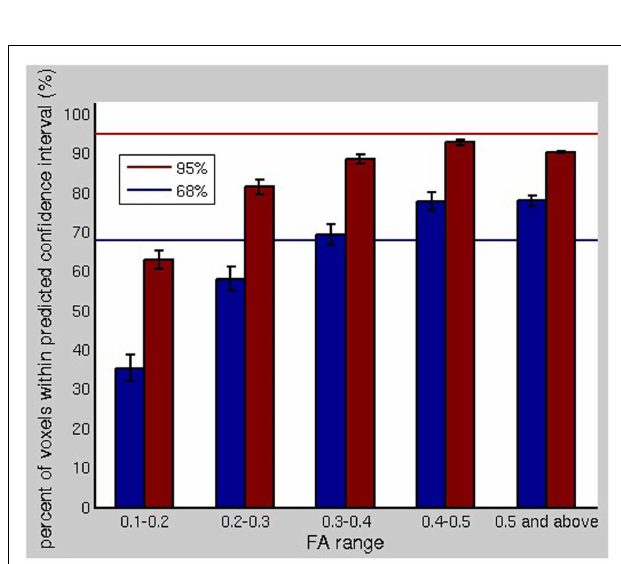
FIGURE 6 |The comparison of the bootstrap uncertainty profiles for fiber orientations is shown .The blue and red bars show the percent of the voxels in the brain for which the fiber orientations, computed without bootstrapping, lay within the 68 and 95% bootstrap-predicted confidence intervals for the fiber orientation using a separate dataset. For major fiber tracts (i.e., FA > 0.3), the correspondence between the observed variability in the fiber ODF maxima and the variability predicted by the bootstrap was very